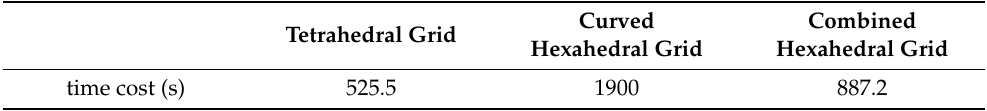
Table 7. Time cost of complete inversion